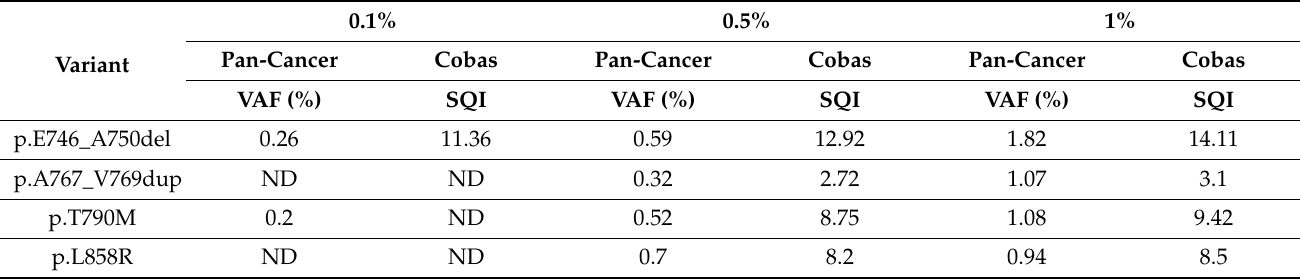
Table 4. Comparison between Oncomine Pan-Cancer Cell-Free Assay and Cobas-EGFR assay for detection of EGFR mutations using the reference